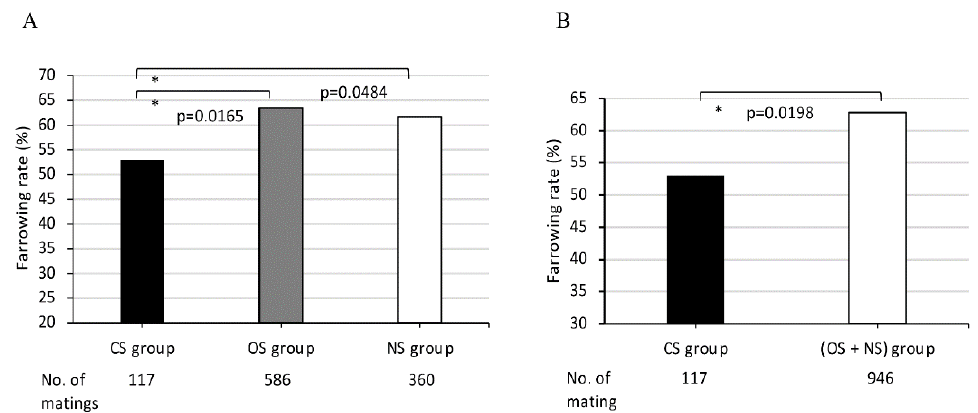
Figure 2. Comparison of farrowing rates in MMPs among ( A ) three groups CS, OS, NS, and ( B ) between two groups, CS and (OS + NS). CS, completely sharing SLA class II haplotypes or DRB1 alleles between partners; OS, sharing only one SLA class II haplotype or DRB1 alleles between partners; NS, non-sharing, that is, SLA class II haplotypes or DRB1 alleles were completely different between partners. X-axis shows CS, OS, and NS groups ( A ), and CS and (OS + NS) groups ( B ), and the number of matings for each group. Y-axis shows farrowing rate as indicated by the ratio (%) of the number of deliveries to the number of matings, expressed as the mean value (bar). Black and white bars represent lower and higher farrowing rate, respectively, of the mean values. Gray bars represent intermediate farrowing rate of the mean values between those of black and white bars. Probabilities of significant differences among groups are indicated by single ( p < 0.05)